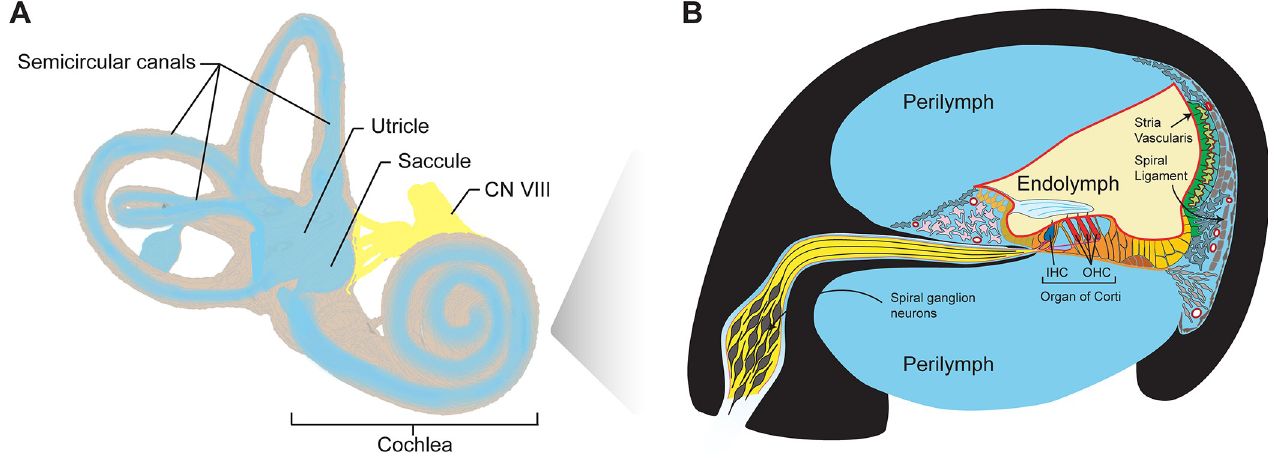
Fig 1. Schematic of the inner ear and cochlear cross section. (A) The inner ear includes the organ of hearing (i.e. the cochlea), and five vestibular end-organs: the saccule, utricle and three semicircular canals. Modified after Blausen.com staff (2014). "Medical gallery of Blausen Medical 2014". WikiJournal of Medicine 1 (2). DOI:10.15347/wjm/2014.010. ISSN 2002-4436. (B) Perilymph (blue) is the proximal fluid of the inner ear that bathes most cells in the cochlea and fills the scala vestibuli and scala tympani. IHC, inner hair cells (dark blue) and OHC, outer hair cells (red) are part of the organ of Corti. Endolymph fluid is pseudocolored in light yellow. Other structures of interest are labelled as shown, and include the stria vascularis (green), fibrocytes of the spiral ligament (gray), fibrocytes of the spiral limbus (pink), spiral ganglion neurons (SGNs, bright yellow), different types of supporting cell of the epithelial gap junctional network (different shades of